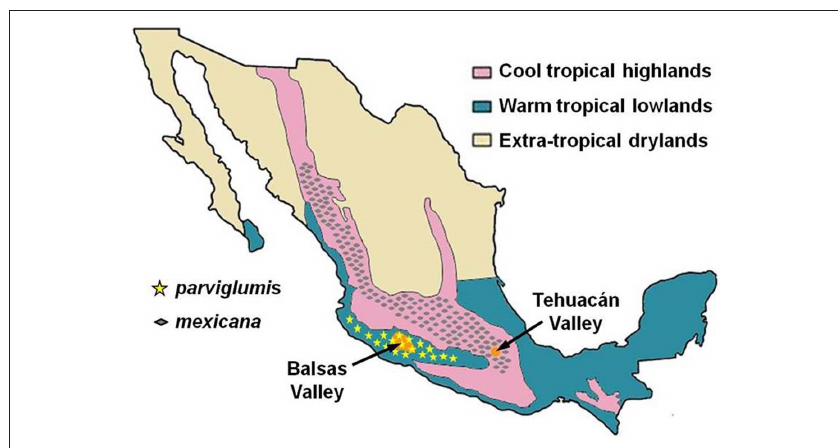
Figure 1 | geographical distribution of parviglumis and mexicana teosintes. Map of Mexico showing major ecological zones. The Balsas and Tehuacán Valley regions also shown. Modified after McClung de Tapia (1992) and Matsuoka et